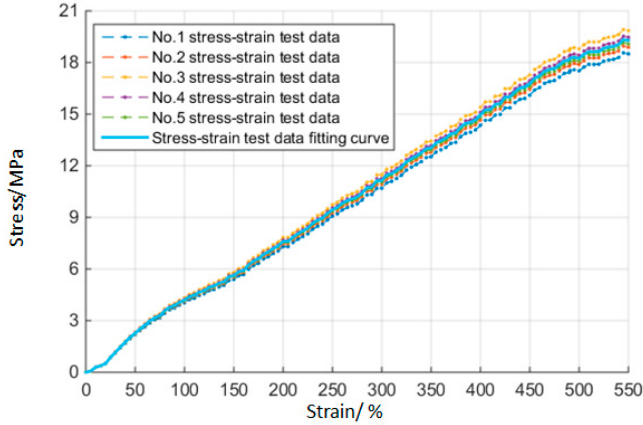
Figure 4. Stress-strain fitting curves for rubber.